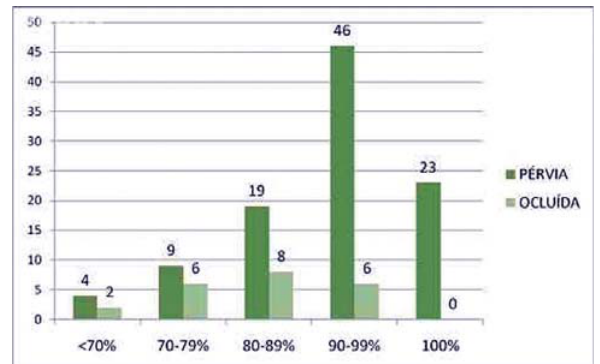
Fig. 4 - Evolução da perviedade dos enxertos de AR, quanto à lesão obstrutiva da artéria coronária